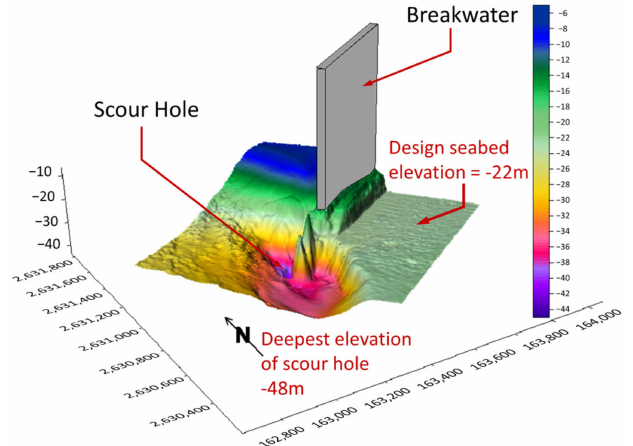
Figure 2. The scour hole in front of Mailiao Port West